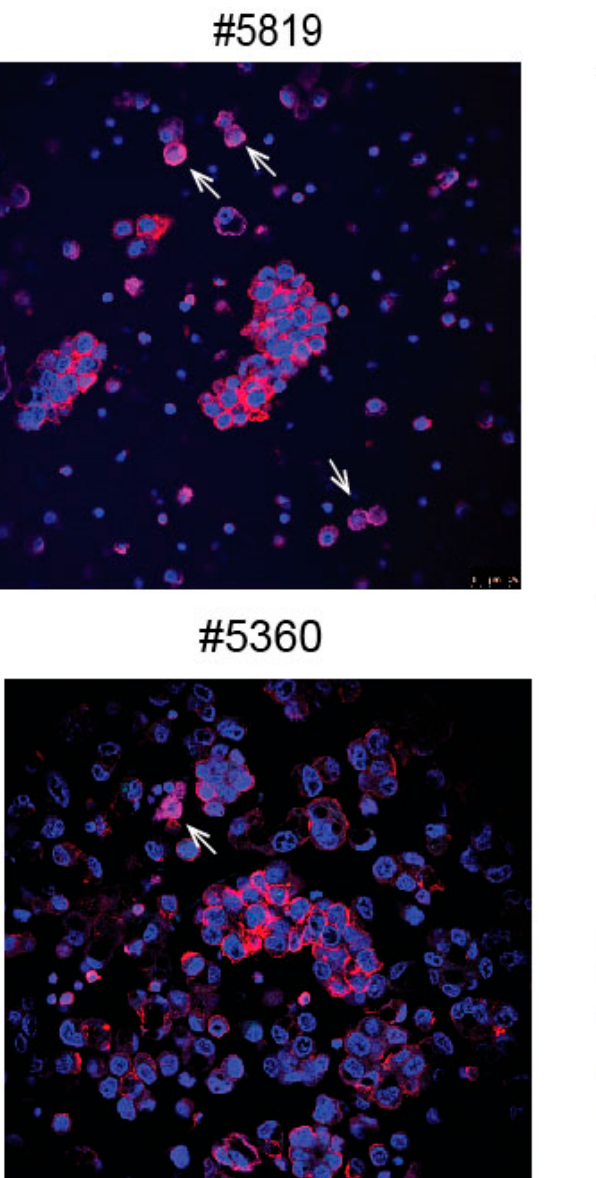
Figure 9. IF staining of the indicated ovarian cancer cell lines with DAPI and α SMA and FN1 MAbs (merged) either grown as monolayer cultures ( A ) or forming 3D aggregates in Matrigel ( B ).